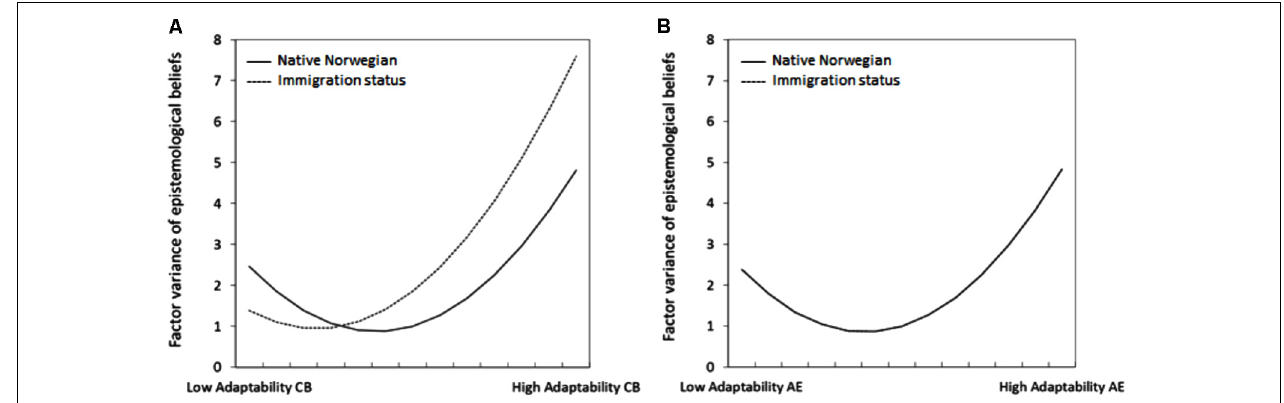
FIGURE 4 | Interaction effects between students’ immigration status and (A) cognitive-behavioral adaptability (CB) and (B) affective-emotional adaptability (AE) on the factor variance of epistemological beliefs in the development of scientific